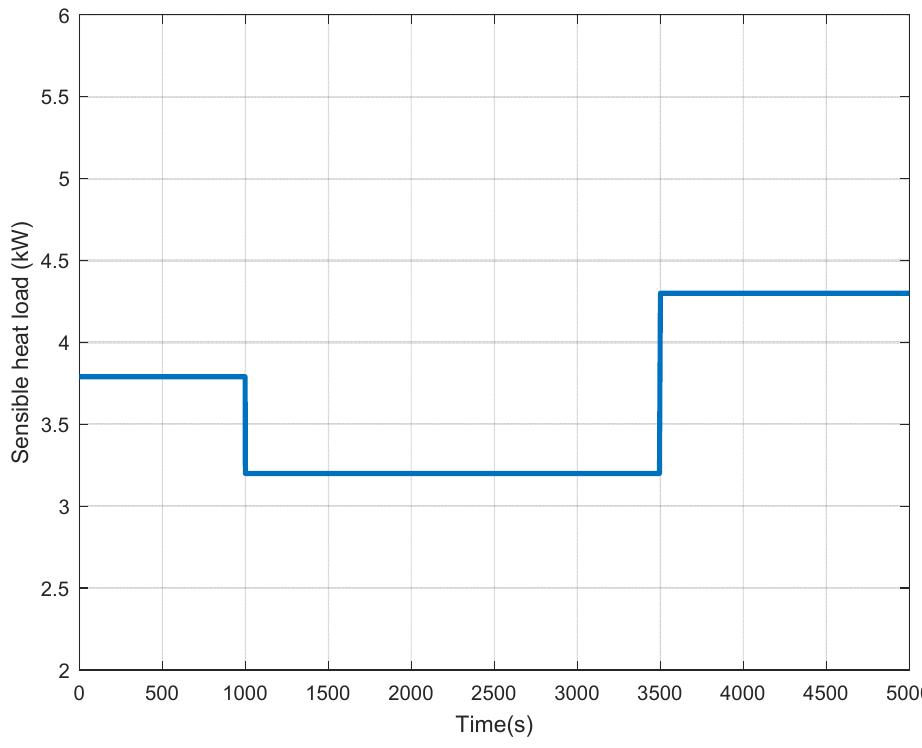
Figure 5. Variation of sensible heat load in the conditioned space.